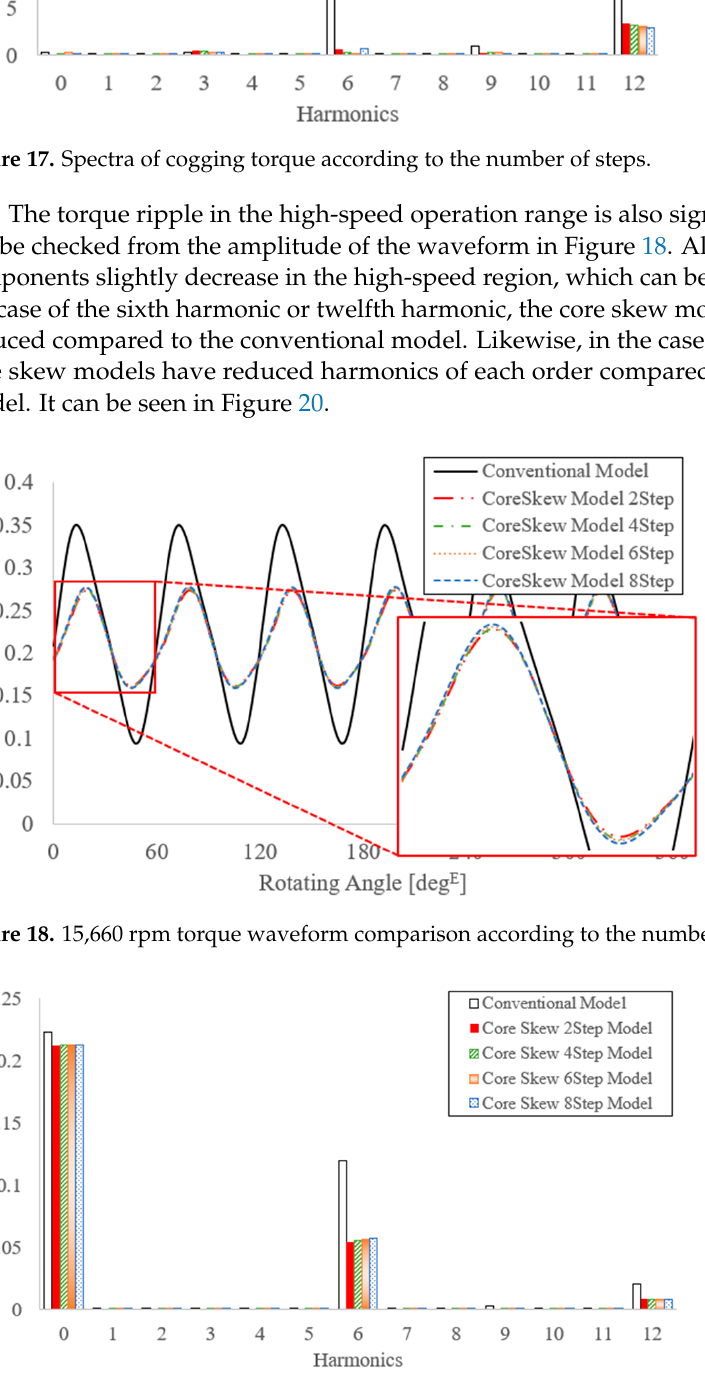
Figure 19. 15,660 rpm torque spectra according to the number of steps.